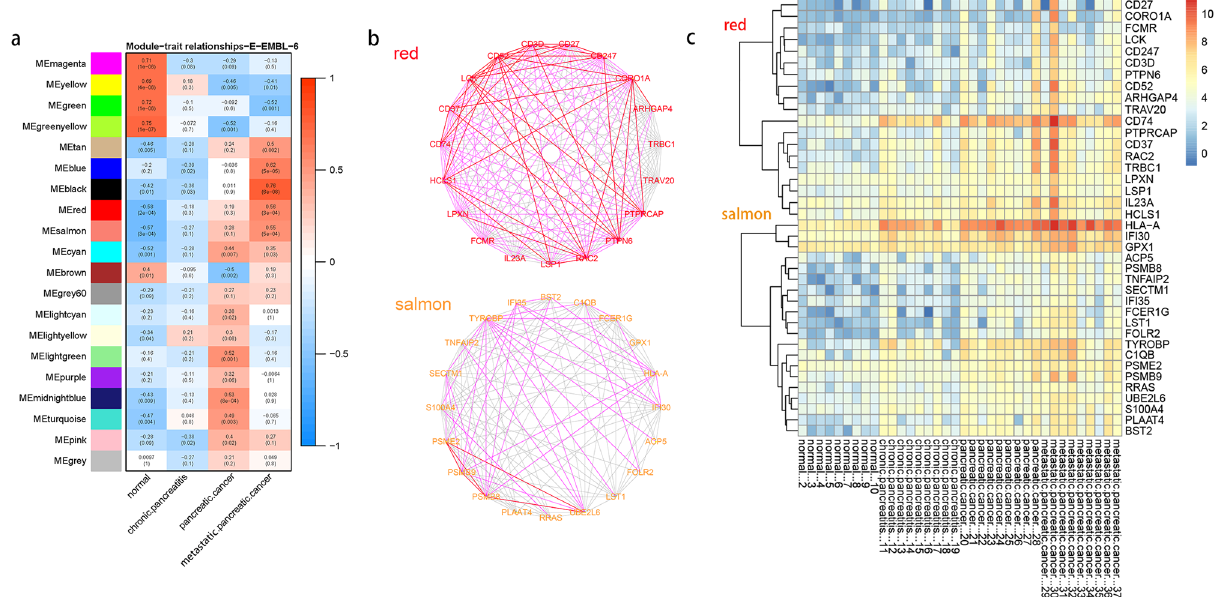
Figure 8. Potential pancreatic disease-related genes selected by WGCNA and further analysis. ( a ) Modules correlated with normal and diseased pancreatic tissue. ( b ) The verification of co-expression of the top20 genes in red and salmon modules in STRING and coexpedia. The verification result is represented by a graph drawn by Cytoscape. The dark lines show the co-expression in this research. The pink lines show the co-expression verified by STRING or coexpedia at the same time. The red line shows the co-expression verified by STRING and coexpedia. ( c ) The heatmap of top20 genes in red and salmon module. The expression has been converted by log2 (x + 1).